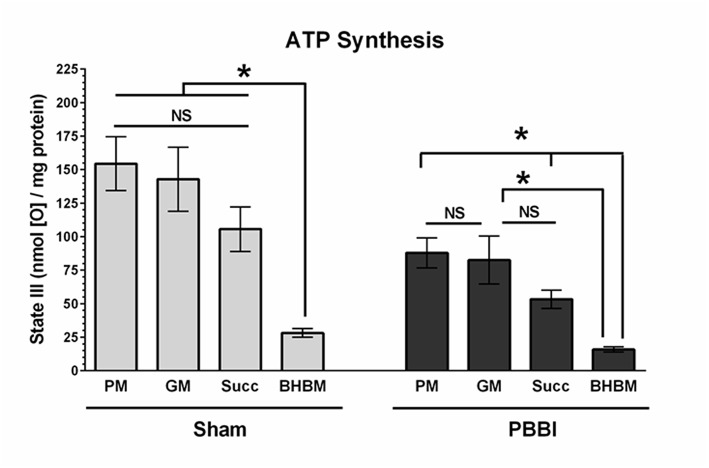
Comparison of ATP synthesis rates with-in the experimental group. The ATP synthesis rates of the four substrates (i.e., PM, GM, Succ, and BHBM) were compared with-in sham or PBBI group. In the sham group, the BHBM showed significantly less ATP synthesis than any other substrates (PM=GM=Succ>BHBM, *p < 0.05). In the PBBI group, the ATP synthesis of PM, Succ, and BHBM were significantly distinct amongst each other (PM = GM>Succ>BHBM, *p < 0.05). Bars represent group means ± SEM (n = 5 animals / group). *p < 0.05 compared within four substrates groups of sham or PBBI (ANOVA, Fisher post-hoc test).